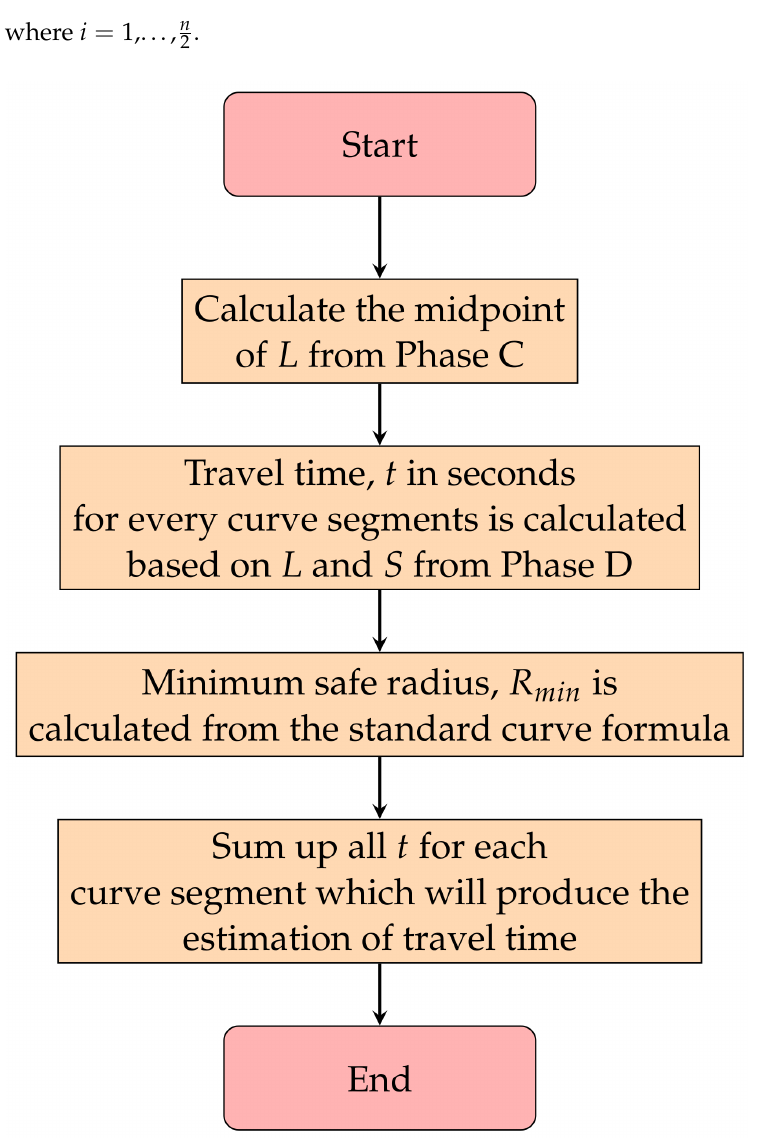
Figure 7. Flowchart for estimating of travel time from initial to final points of the